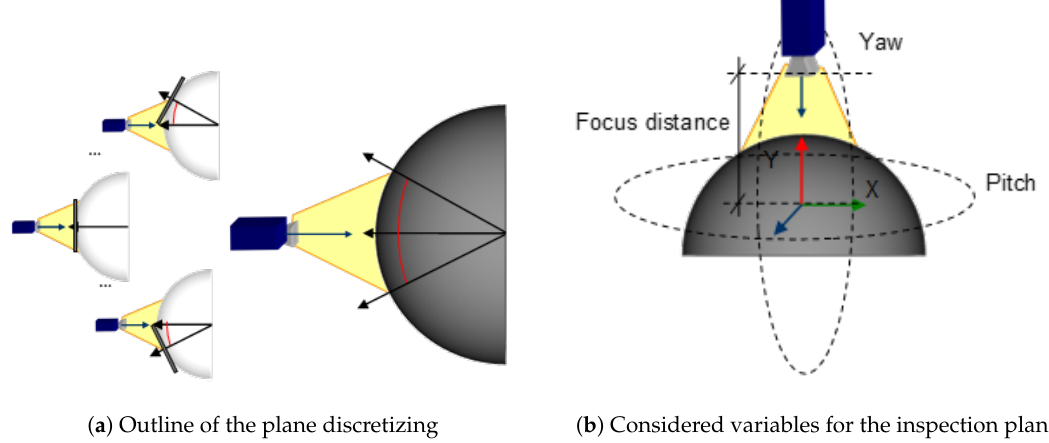
Figure 16. Essential considerations for transferring the conclusions of experimental values to a specific inspection of an